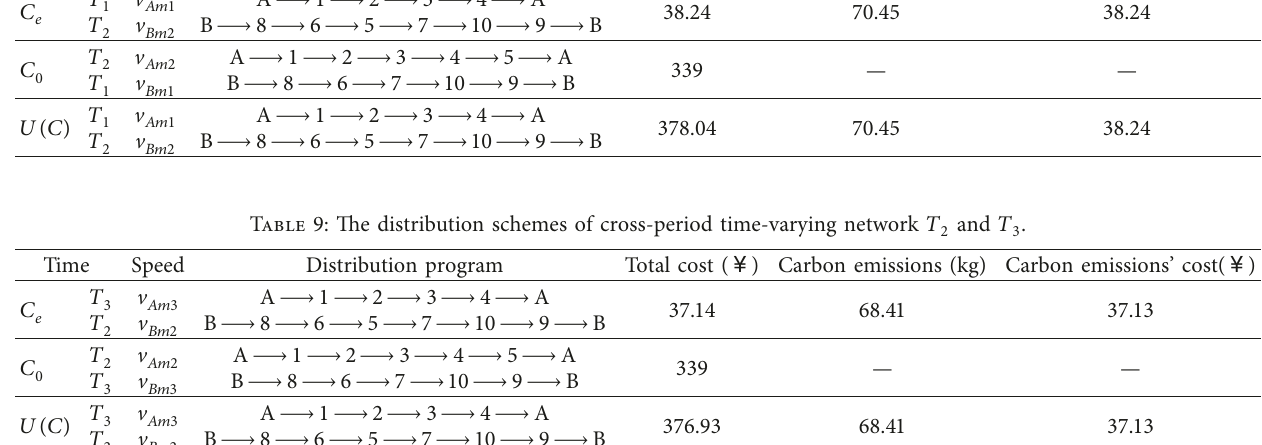
Table 8: The distribution schemes of cross-period time-varying network T